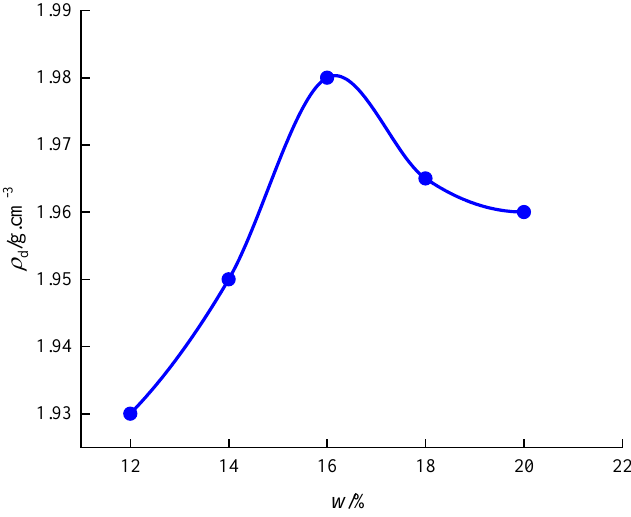
Figure 10. Compaction curve of natural waste silt.